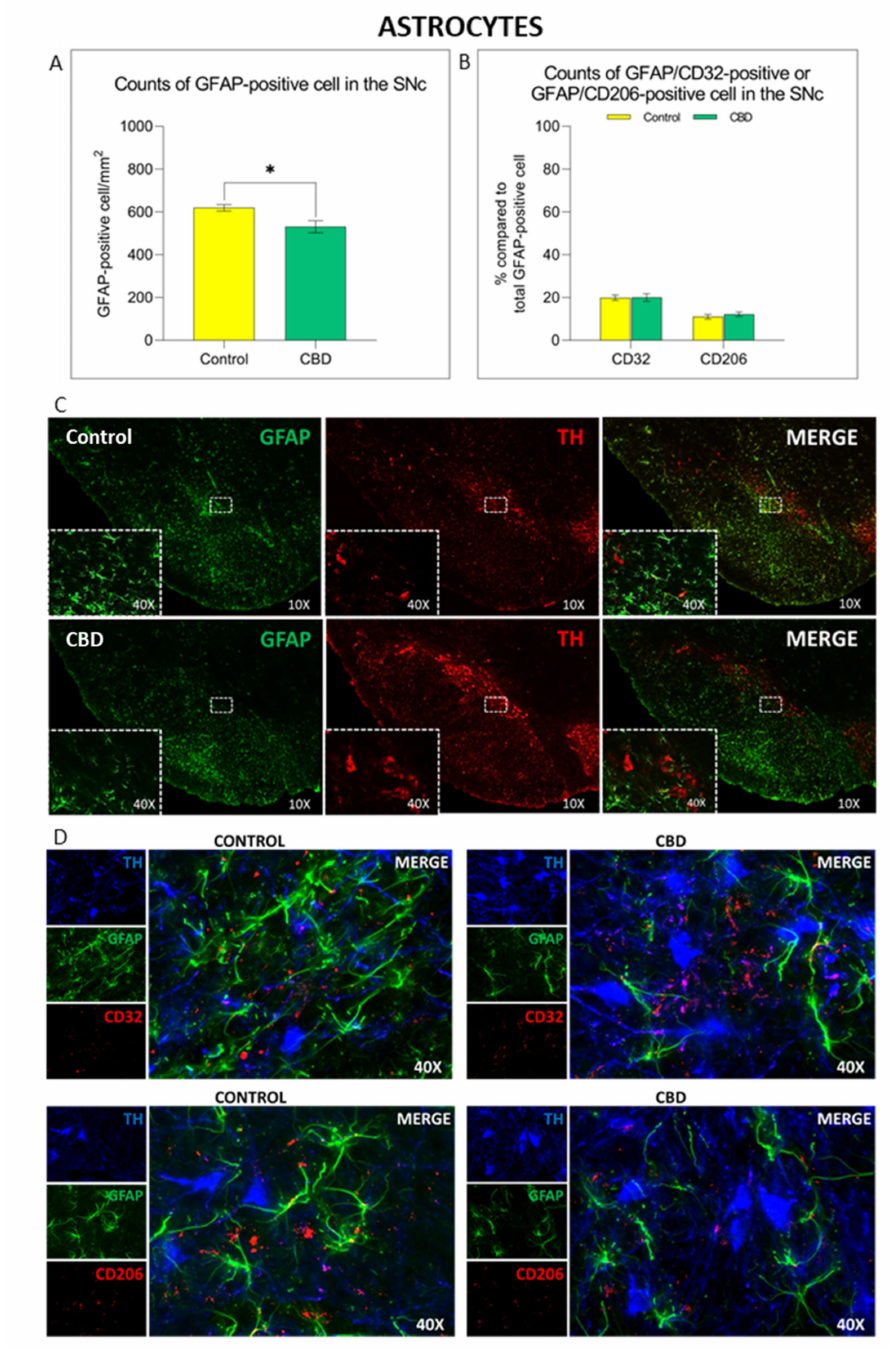
Figure 5. Immunomodulatory effect of chronic treatment with CBD on astrocytes activation and polarization in the SNc. ( A ) Comparison of GFAP + cell density in the SNc in both experimental groups. ( B ) Comparison of astrocyte polarization in SNc in both experimental groups. ( C , D ) Representative images of the astrocyte activation and polarization in the SNc in both experimental groups. Results are expressed as mean ± SEM. * p < 0.05 vs. control t = 2937, df = 13, Student’s t -test unpaired two-tailed. N = 7 to 8 in each